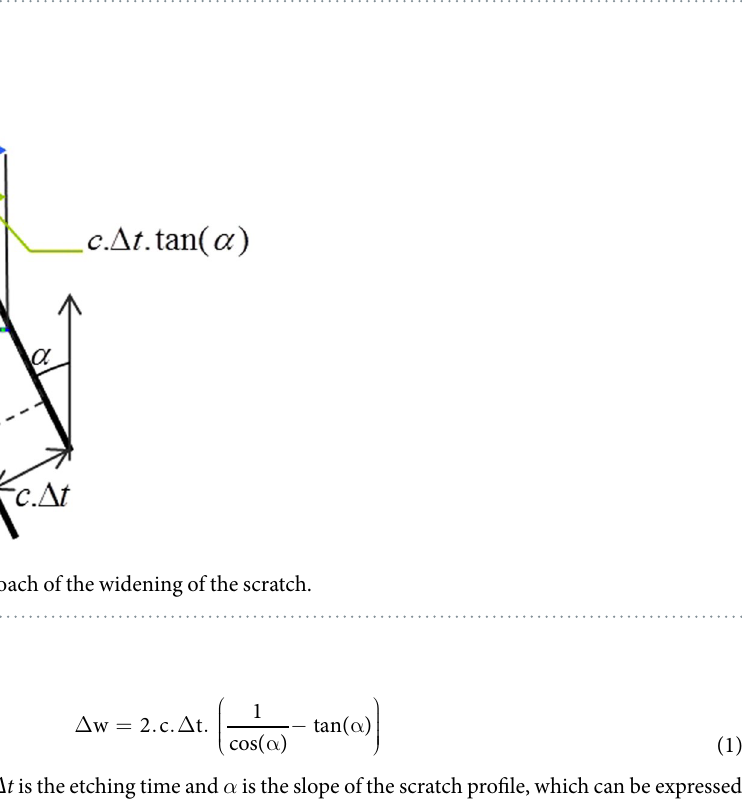
Figure 5. Modeling of chemical erosion using Huygens wavelets for a simplified scratch.